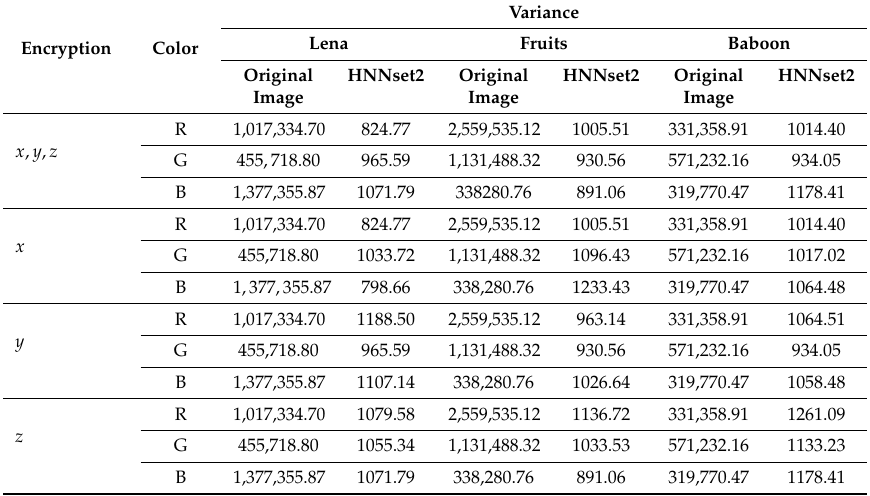
Table 11. Variance of the histograms for the Lena, Fruits and Baboon images using the sequences generated by HNNset2.